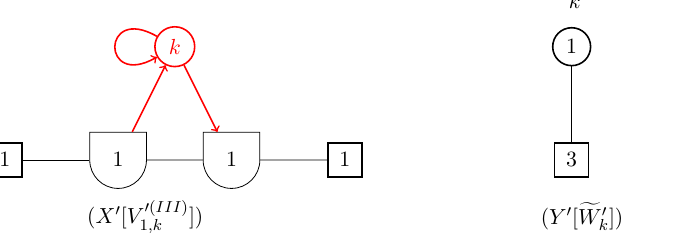
Figure 25 . The third realization of the vortex defect in the theory X 0 via a 3d-1d